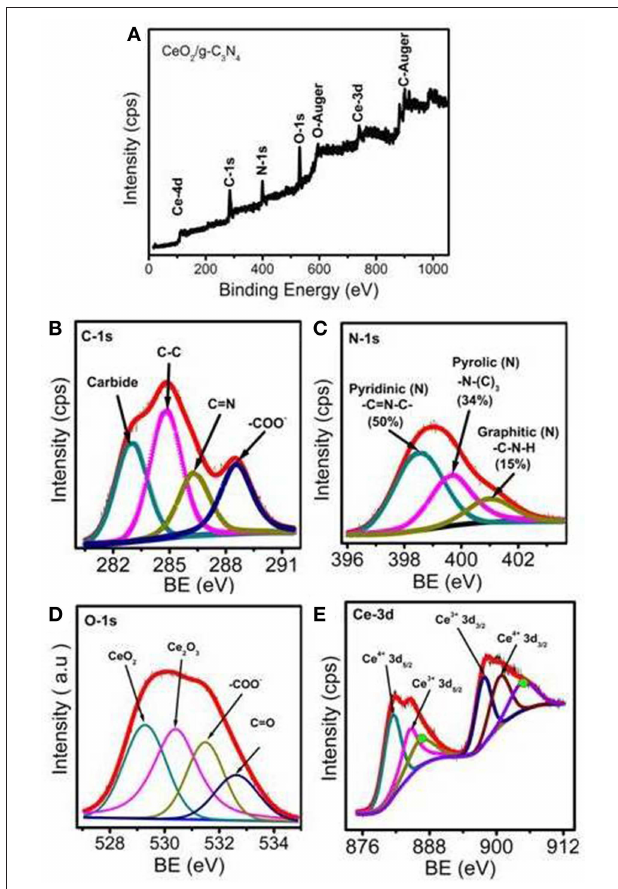
FIGURE 3 | (A) XPS survey scan of CeO 2 / g-C 3 N 4 , Deconvoluted XPS spectrum of (B) C 1s, (C) N 1s, (D) O 1s, (E) Ce